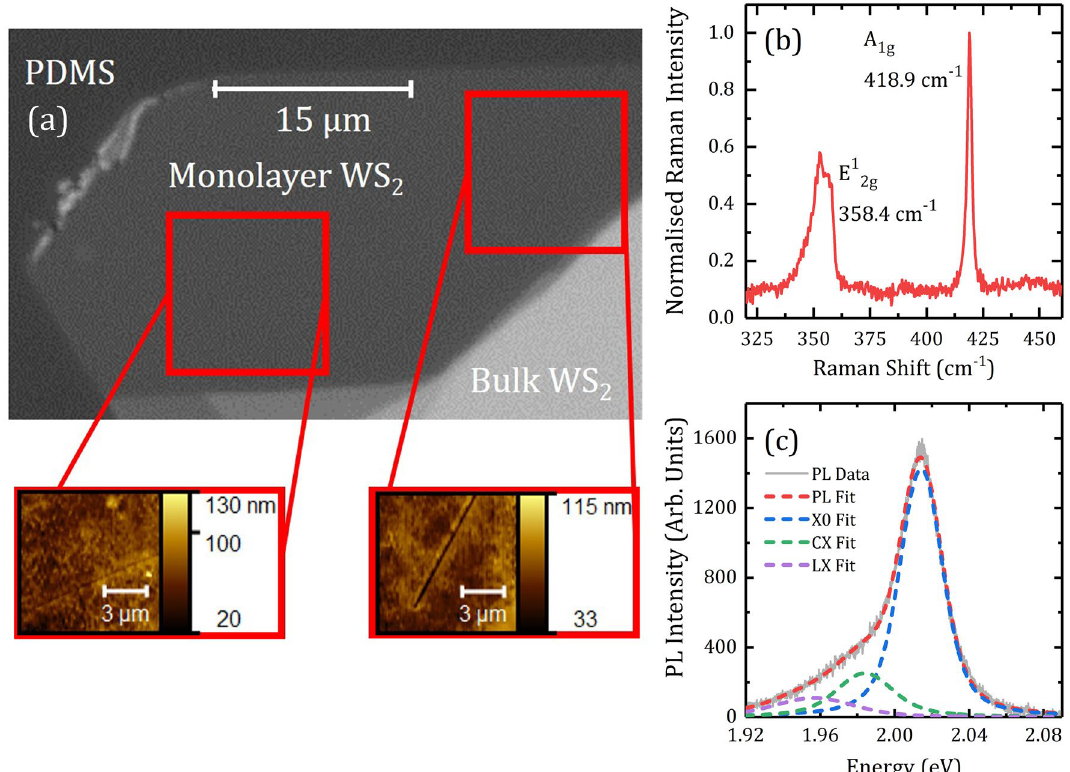
Figure 1. ( a ) Optical image of a WS 2 monolayer flake obtained using dry exfoliation onto PDMS, AFM microscopy reveals crack defects, highlighted in red boxes. ( b ) A typical confocal Raman spectrum for the flake in ( a ), taken at room temperature with 633nm excitation. ( c ) A typical PL spectrum, taken at 532